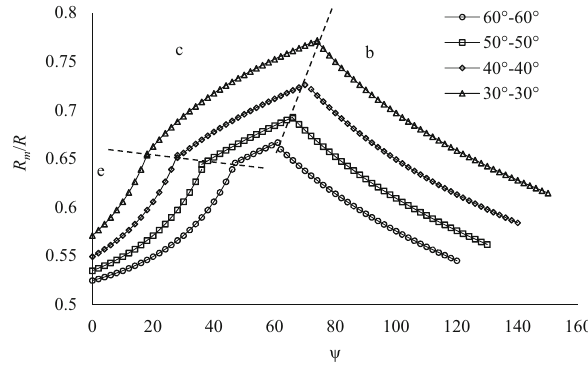
Fig. 9 Normalized threshold radius, R m for different tube shapes